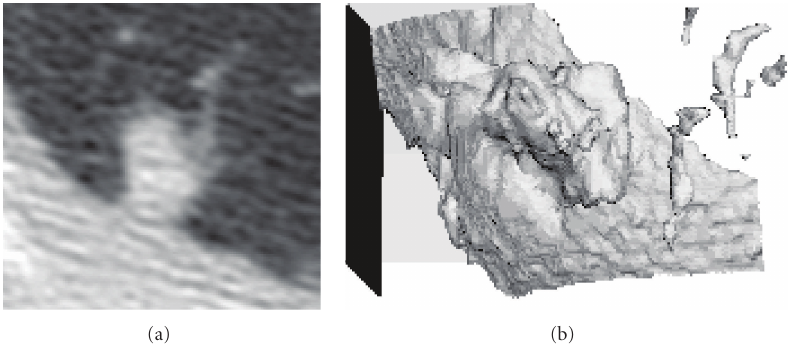
Figure 1: Example of a juxtapleural nodule, with (a) one central slice from CT scan and (b) 3D visualization of region of interest. algorithm to segment nodules on the chest wall as well